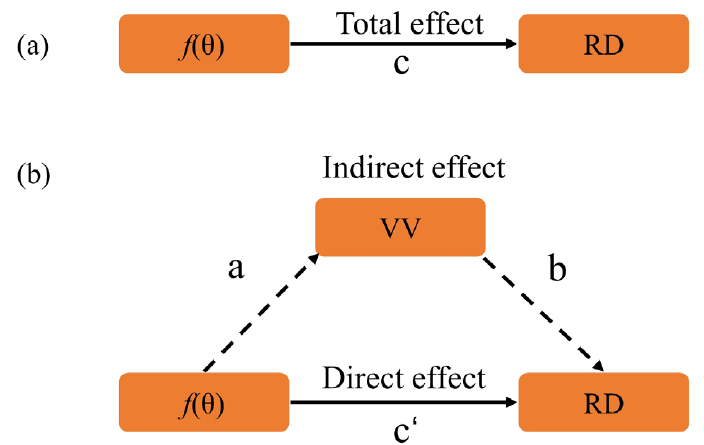
Figure 5. Diagram of mediation analysis: ( a ) overall relationship between dependent and indepen- dent variables; ( b ) direct and indirect effects between independent and dependent variables. In the figure, a,b represents the indirect effect coefficient, c represents the total effect, and c' represents the direct effect coefficient.